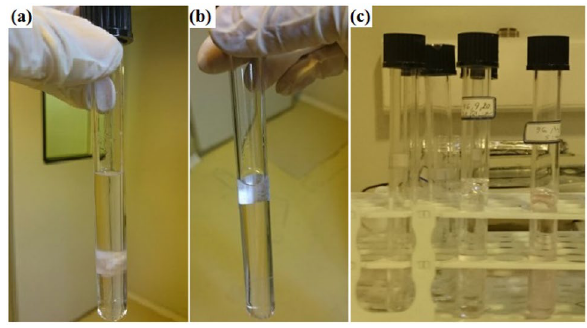
Fig. 4 The sol–gel solution: a Heterogeneous solution at the begin- ning, b Homogeneous solution after 15 h and c The gel after 48